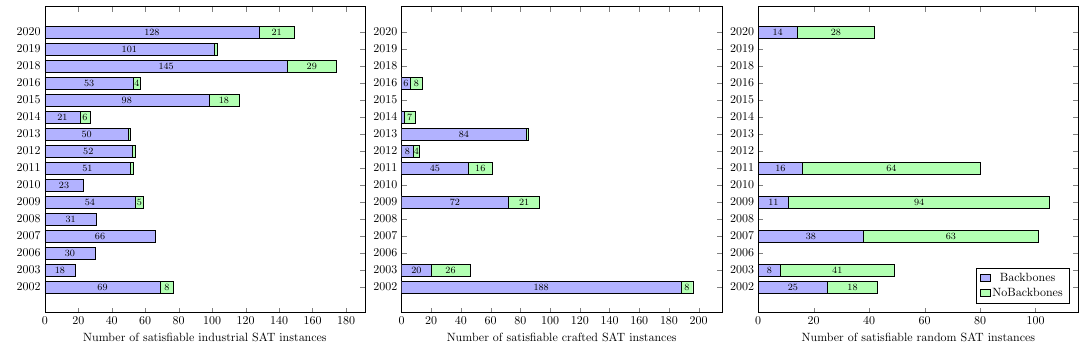
and without backbones. In contrast to random instances, most satisfiable industrial and crafted instances preserve the backbone structure. It is due to the fact that the backbone sizes for most random instances are controlled by being set to zero prior to generation.